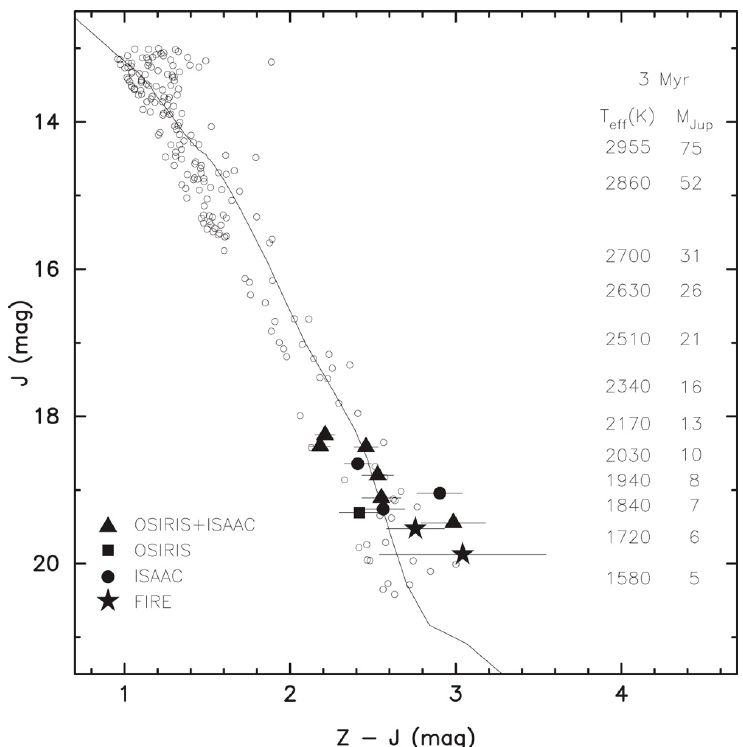
Figure 7. Optical/near-infrared color–magnitude diagram of σ Orionis low-mass star, brown dwarf, and iPMO candidates from [186] (open circles) and [145] (filled symbols, with new spectroscopic follow-up; see legend). Solid line: 3 Ma isochrone [40]. Columns: theoretical effective temperatures and masses (in M Jup ) for this isochrone. Reproduced with permission from [145].